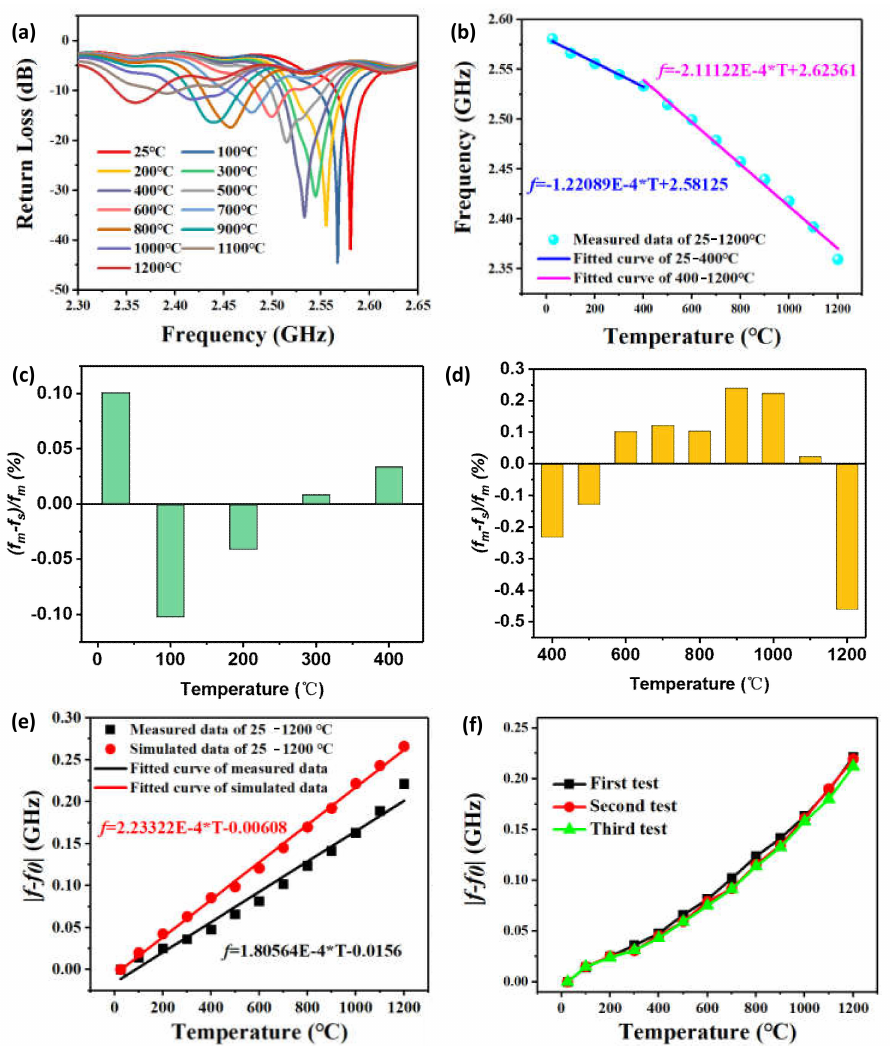
Figure 10. ( a ) The resonant frequency curves within the temperature of 25–1200 ◦ C. ( b ) Linear fitting curves. ( c ) Nonlinearity errors in the temperature range of 25 to 400 ◦ C. ( d ) Nonlinearity errors in the temperature range of 400 to 1200 ◦ C. ( e ) Linear fitting curves of simulation and measurement. ( f ) Repeatable